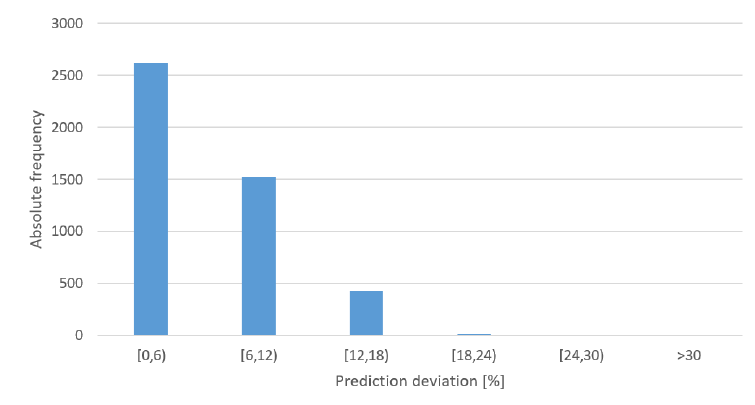
Figure 15. Prediction deviation of the elongation at break.